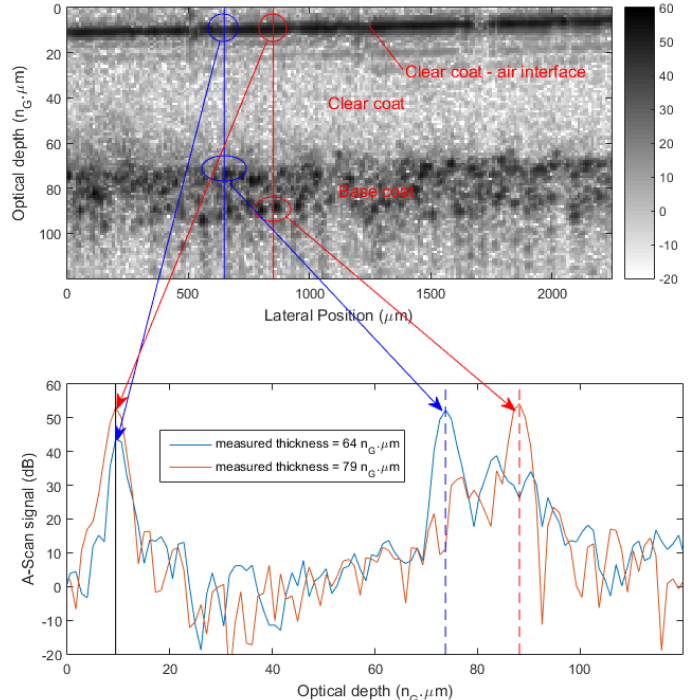
Figure 4. ( Top ) LF-FD-OCT image of silver metallic paint sampler (Figure 3b) with two (blue and red) A-Scan locations marked. ( Bottom ) Plot of the red and blue A-Scans, with the apparent thickness measured using only the single A-Scan data. The arrows show the correspondence of the A-Scan peaks with location in the B-Scan image.